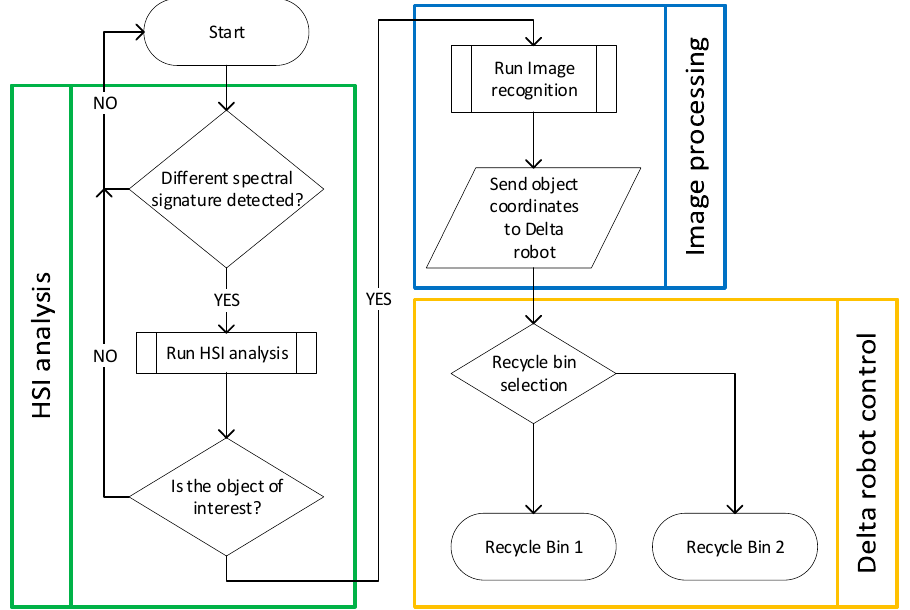
Figure 5. Flow chart diagram of the HSI analysis software.